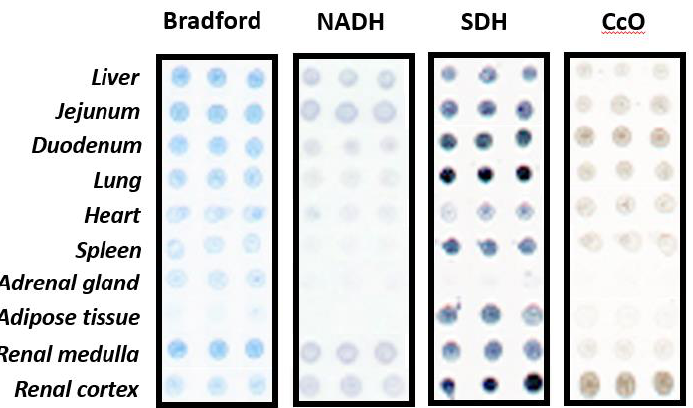
Figure 4. Representative image of human CMMAs showing the immobilized protein (Bradford), the activity of the NADH dehydrogenase (NADH), and succinate dehydrogenase (SDH) together with the activity of citochrome c oxidase (CcO) of the mitochondrial electron transport chain.